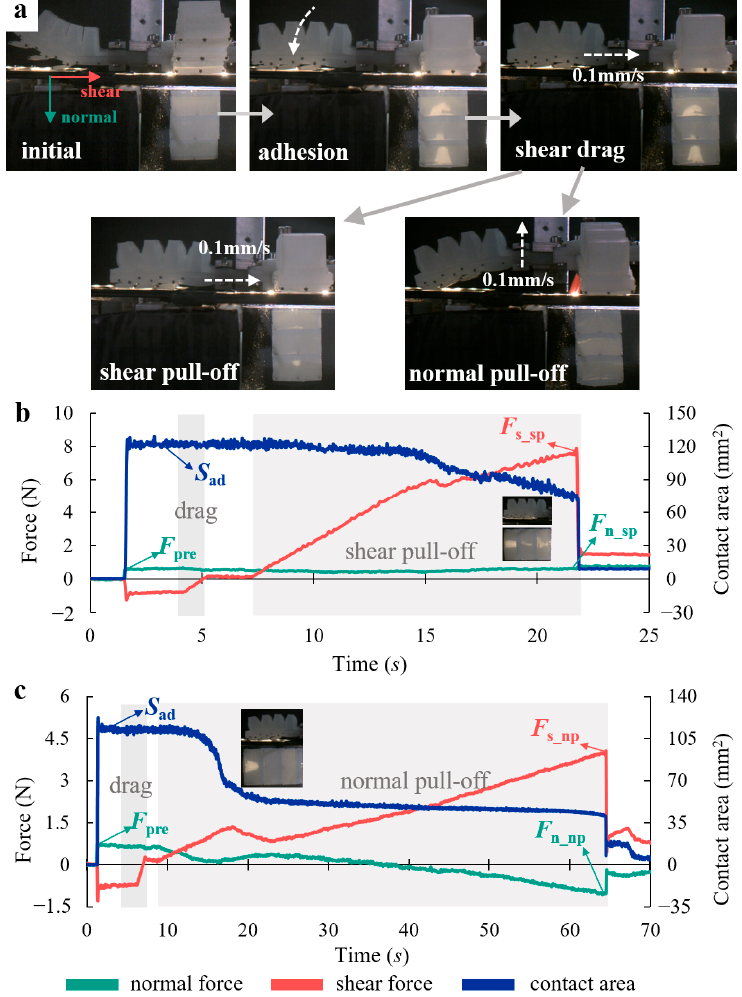
Figure 7. ( a ) Flow of the adhesion performance test of the bio-toe. Typical curves of shear force, normal force, and contact area versus time for the bio-toe in the ( b ) shear and ( c ) normal adhesion performance tests.